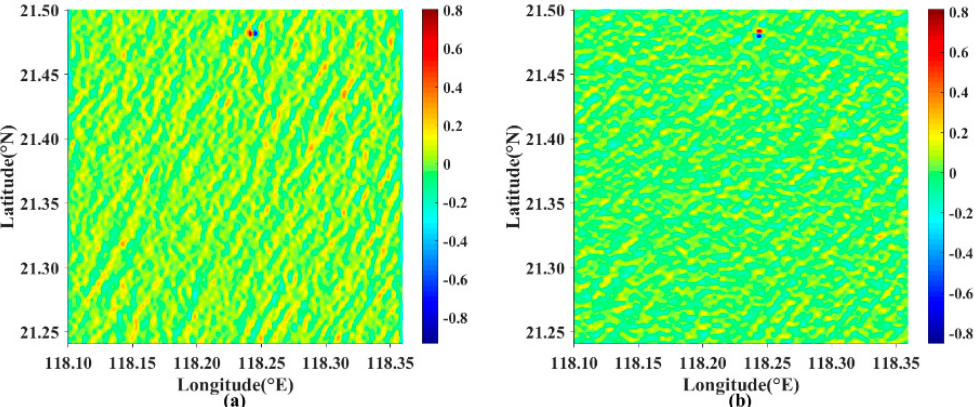
Figure 4. Computed (cid:1859) ( a ) and (cid:1859) ( b ) of the SAR image in Figure 2b. (cid:3052) (cid:1876) Figure 4. Computed g x ( a ) and g y ( b ) of the SAR image in Figure 2b.